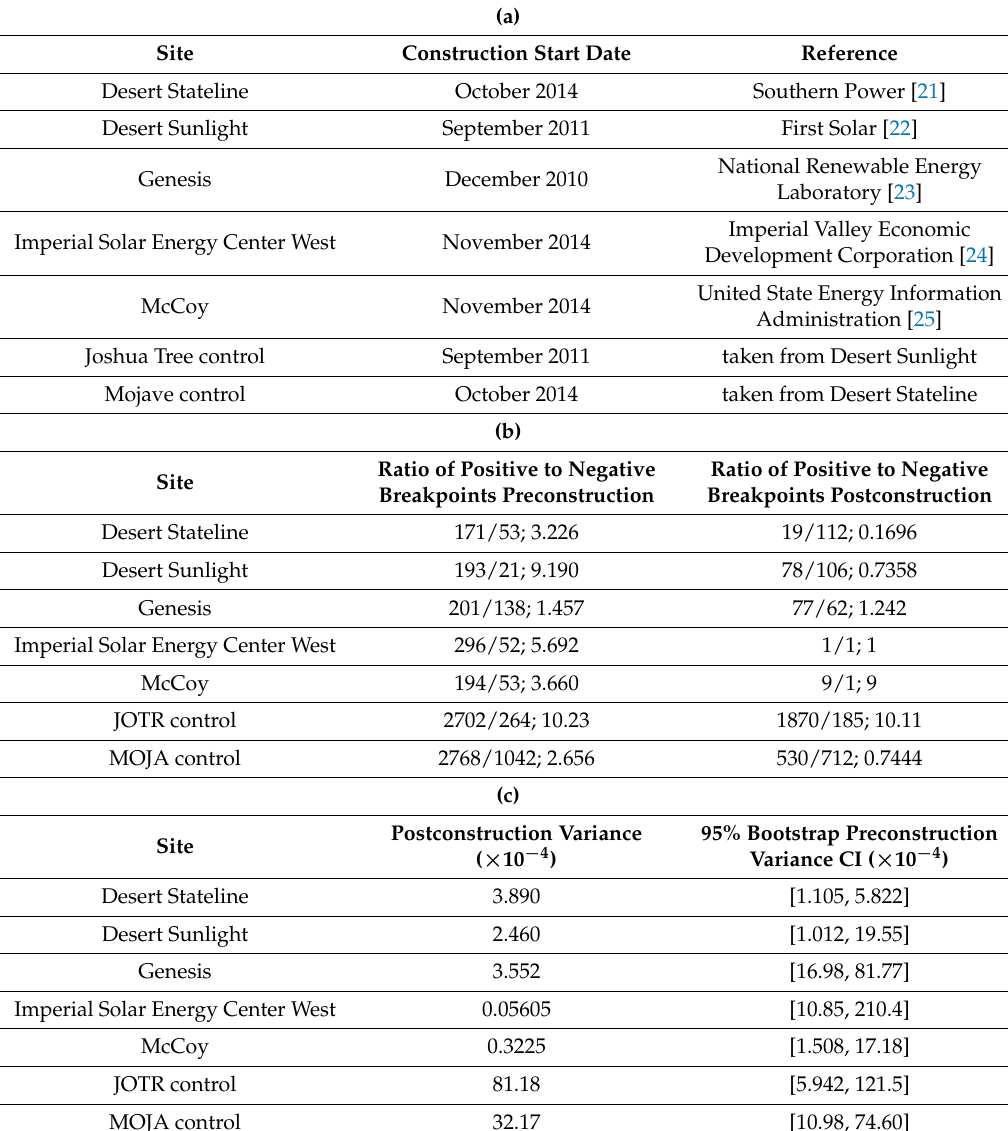
Table 4. ( a ) Construction start dates for solar energy sites. ( b ) Counts of breakpoint sign by site and timing relative to construction date. ( c ) Bootstrap confidence intervals for variance of breakpoint